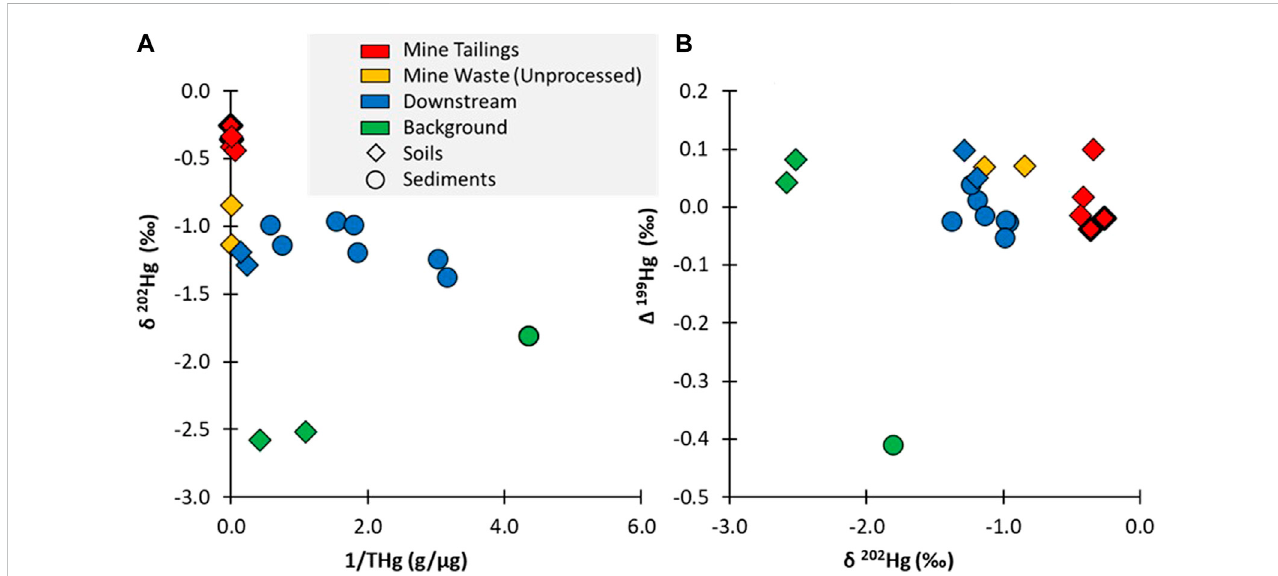
FIGURE 4 (A) showing the δ 202 Hg values plotted against the inverse THg concentration (µg/g); and (B) showing the Δ 199 Hg versus δ 202 Hg values. Note: all soil samples are plotted as diamonds and all sediment samples are plotted as circles. The tailings samples from the old furnace are distinguished from the newer furnace with a heavier black